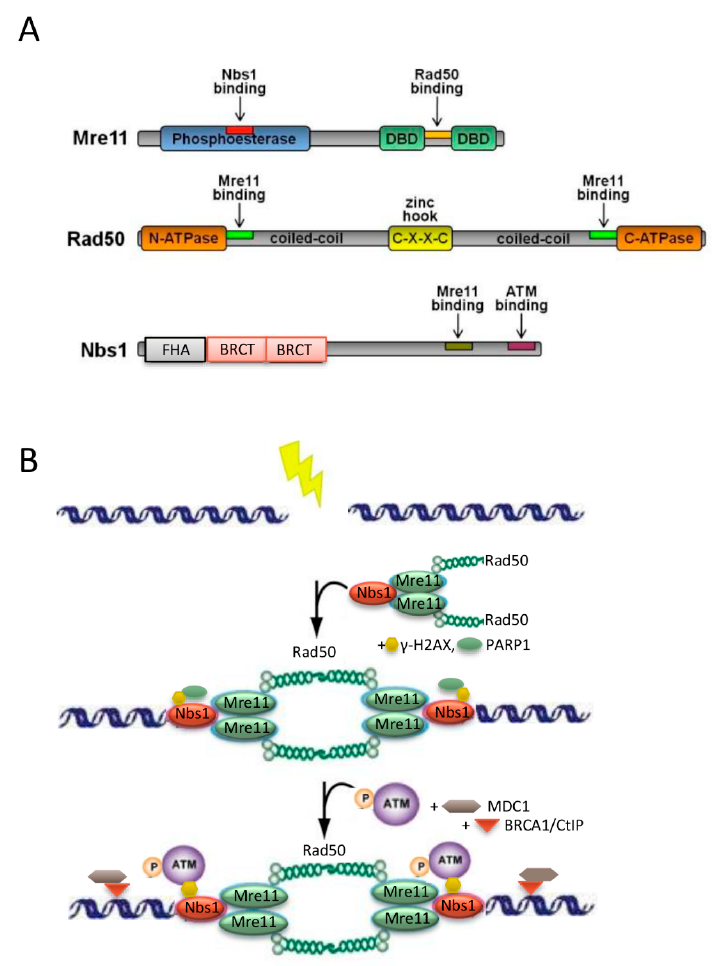
Figure 1. The MRN complex and the DNA-damage response. ( A ) Domain structure of MRE11, RAD50 and NBS1 proteins. ( B ) Model of intermolecular interaction of the MRN complex within the DNA damage response (DDR) pathway, illustrating the initial steps of DDR including exogenous insult (lightning symbol) and the recruitment of MRN complex to the site of DSB by interactions with γ -H2AX (black arrow). See text for details. CXXC, zinc hook; FHA, Forkhead associated domain; BRCT, BRAC1 carboxyl terminus domain; γ -H2AX, the phosphorylated form of H2AX; PARP1, Poly [ADP-ribose] polymerase 1; MDC1, mediator of DNA Damage Checkpoint